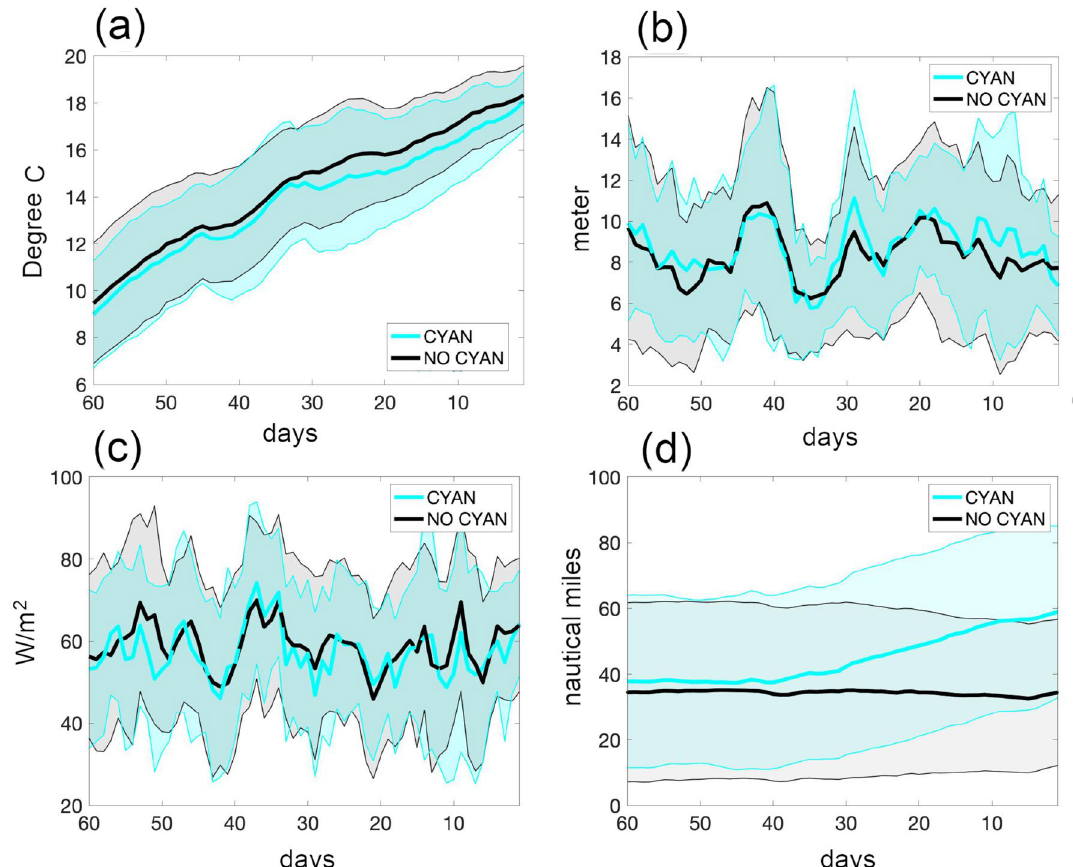
Figure 3. Environmental abiotic conditions relative to bloom events. Cyan colors depict trajectories which later developed blooms. Black and grey trajectories did not develop blooms. Panel ( a ) refers to sea surface temperature, ( b ) to mixed layer depth (MLD), ( c ) to the photosynthetically active radiation (PAR) and ( d ) to the distance to the coast. Curves show are the averages of all blooming and non-blooming trajectories throughout 2010 to 2015 in thick cyan and black lines, respectively. The shaded areas show the respective standard deviations. This figure was created with Matlab (https:// www. mathw orks. com/ produ cts/ matlab.